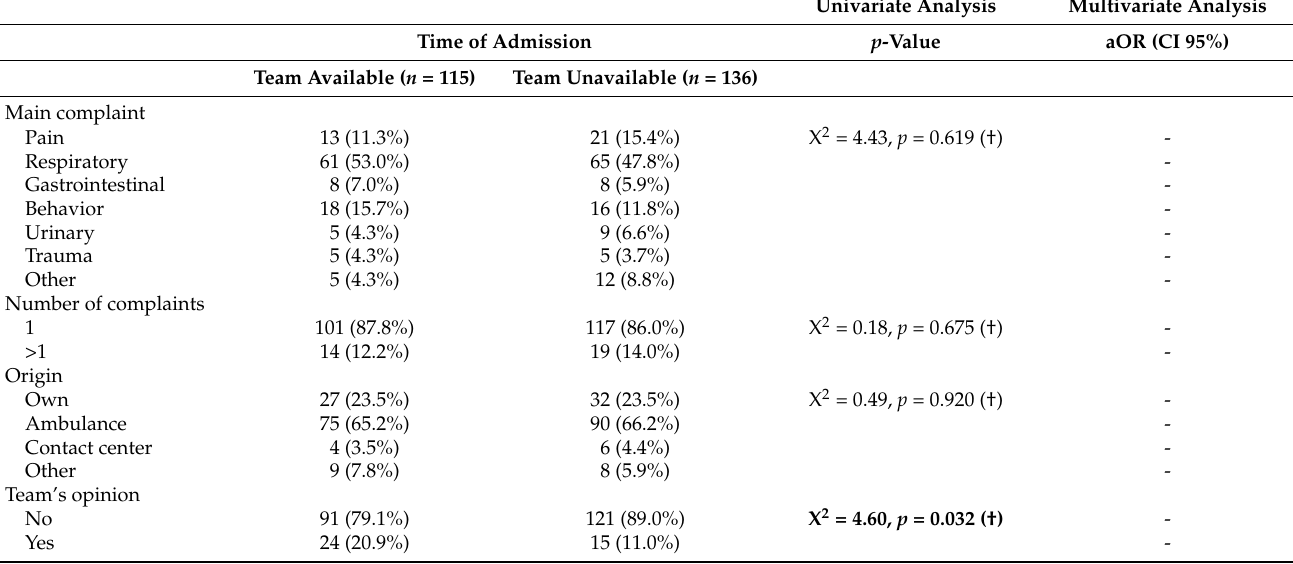
Table 8. Associations with time of admission to the emergency department, including the palliative care team’s work